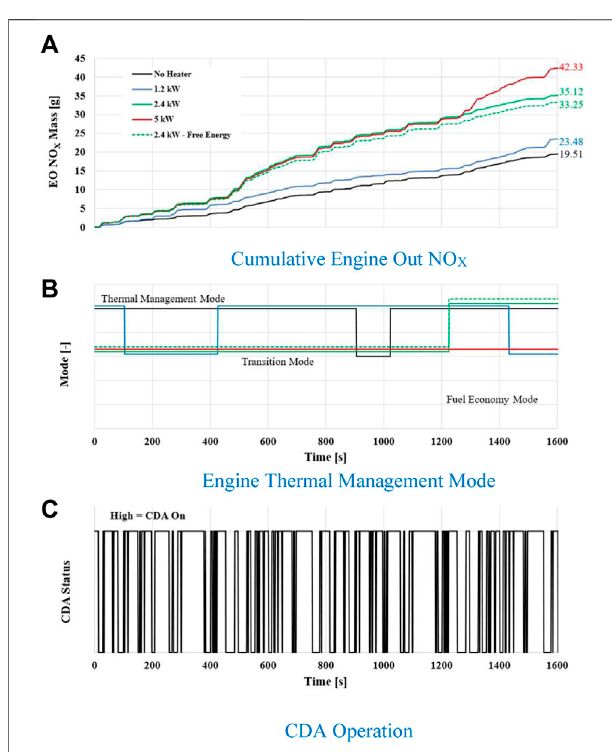
FIGURE 14 | (A – C) Beverage engine